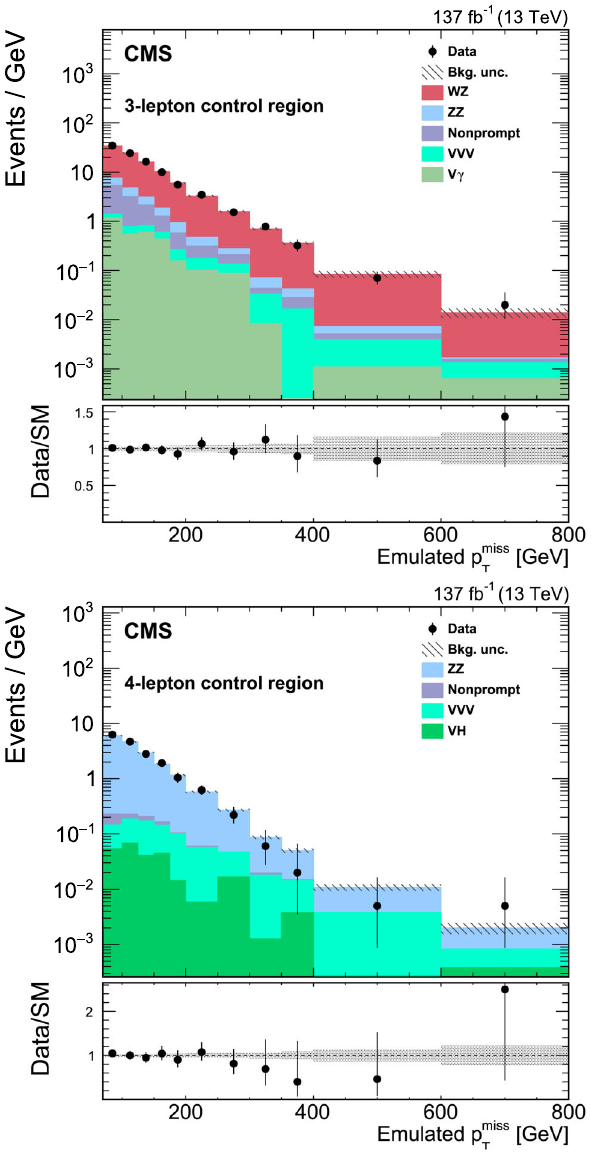
Fig. 2 Emulated p miss distribution in data and simulation for the 3 (cid:3) T (upper) and 4 (cid:3) (lower) CRs. Uncertainty bands correspond to the post- fit combined statistical and systematic components, where the fitting method is described in Sect. 7